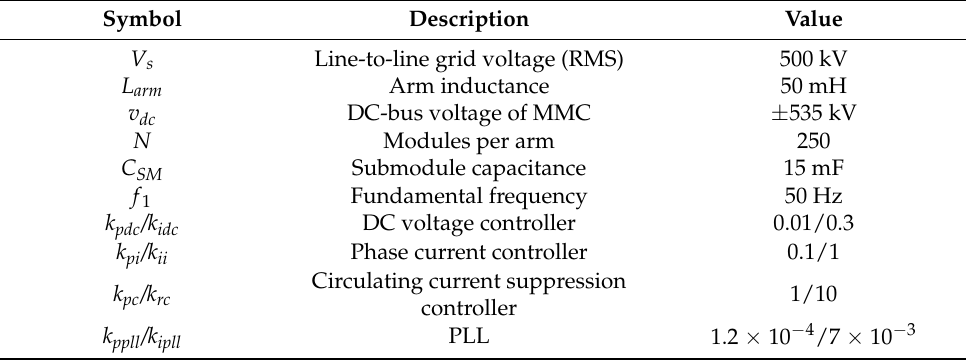
Table 2. Parameters of the practical MMC